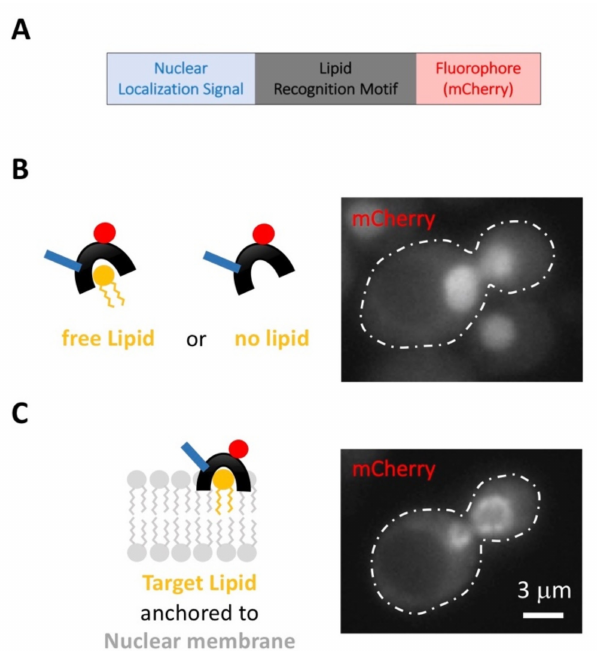
Figure 3. The use of nucleus targeted-fluorescent lipid biosensors permits the monitoring of how specific lipid species evolve under a myriad of experimental situations. ( A ) Basic structure of a nucleus-targeted biosensor. ( B ) Hypothetical example in which the mCherry signal associated with the biosensor emanates from the nucleoplasm of S. cerevisiae cells, which can be ascribed either to a floating lipid or to the absence of any binding target. ( C ) Hypothetical example in which the mCherry signal associated to the biosensor emanates from the nuclear membrane, indicative of either an enrichment of the lipid of interest at this location or, at least, of its